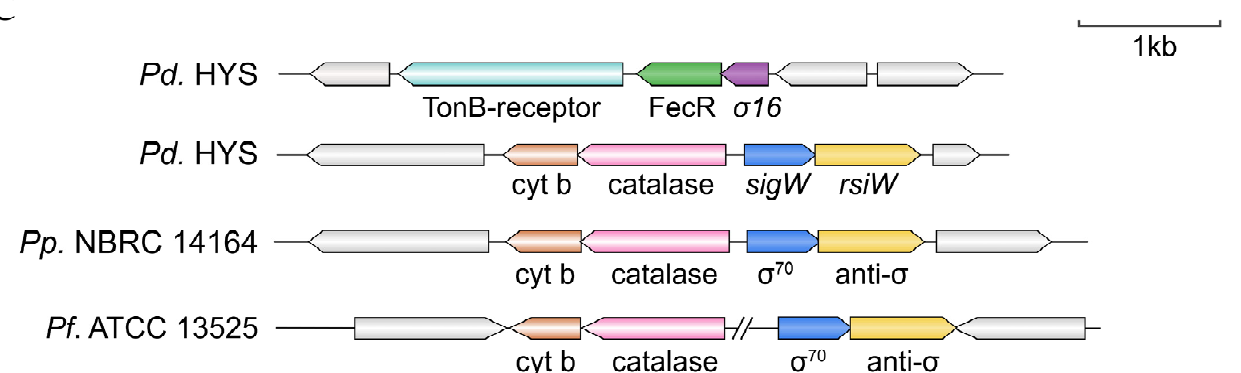
Figure 1. Screening of the ECF σ factors involved in iron metabolism in P. donghuensis HYS. RNA was isolated from the indicated strains grown to the exponential phase at 30°C in liquid MKB culture with or without 30 μ M FeSO 4 ·7H 2 O supplementation. The error bars indicate the mean ± SD of three independent experiments. Statistical significance was calculated using one-way ANOVA Dunnett’s multiple comparison test, ** p < 0.001; *** p < 0.0001. ( A ) The P. donghuensis strain HYS σ factors regulome. ( B ) Expression of 20 ECF σ factors encoded on the genome in different extracellular iron environments. ( C ) Genetic organization of σ 16 and sigW . The locus tags of the corresponding genes in P. putida NBRC 14164 (accession number NC_021505) and P. fluorescens ATCC 13525 (accession number NZ_LT907842.1) are shown under the arrows.